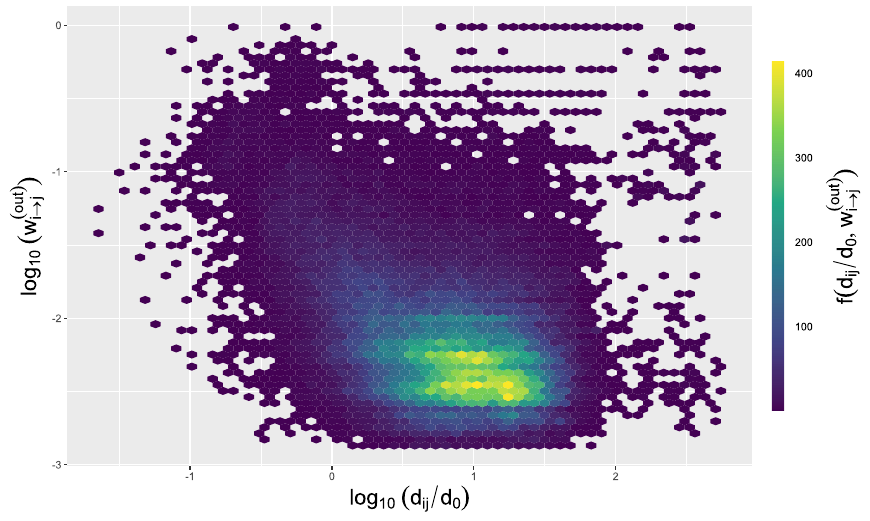
( out ) ) ) for all trip types in the Madrid log 10 ( d ij i → j , d 0